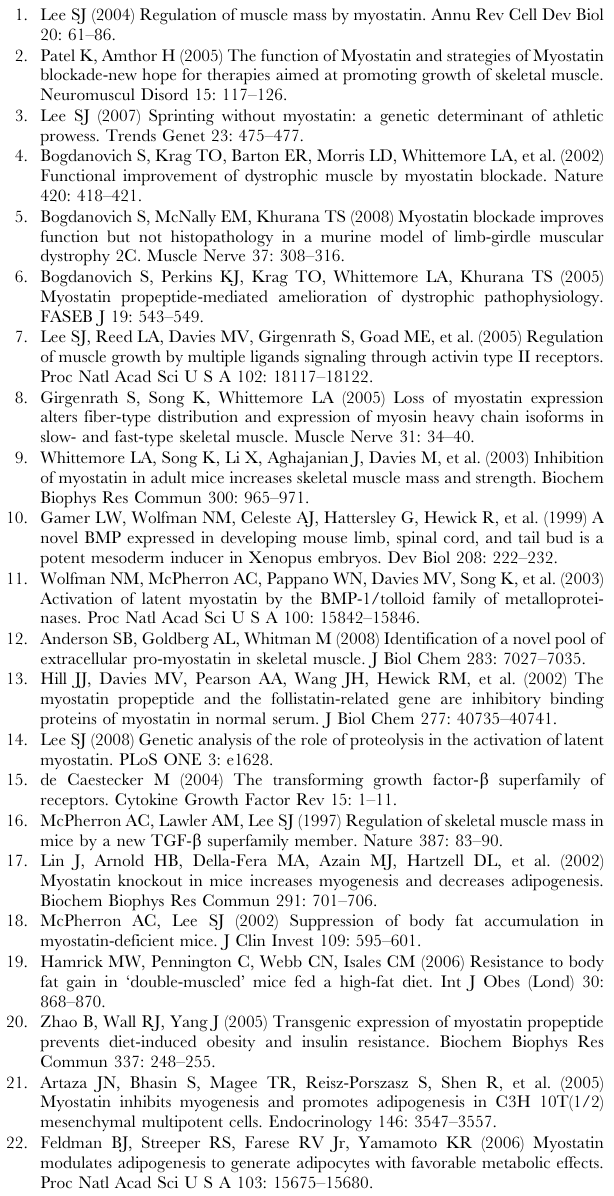
Figure S2 Representative images of H&E stained gonadal fat pads from mutant mice and control littermates on standard chow or high fat diet (HFD).